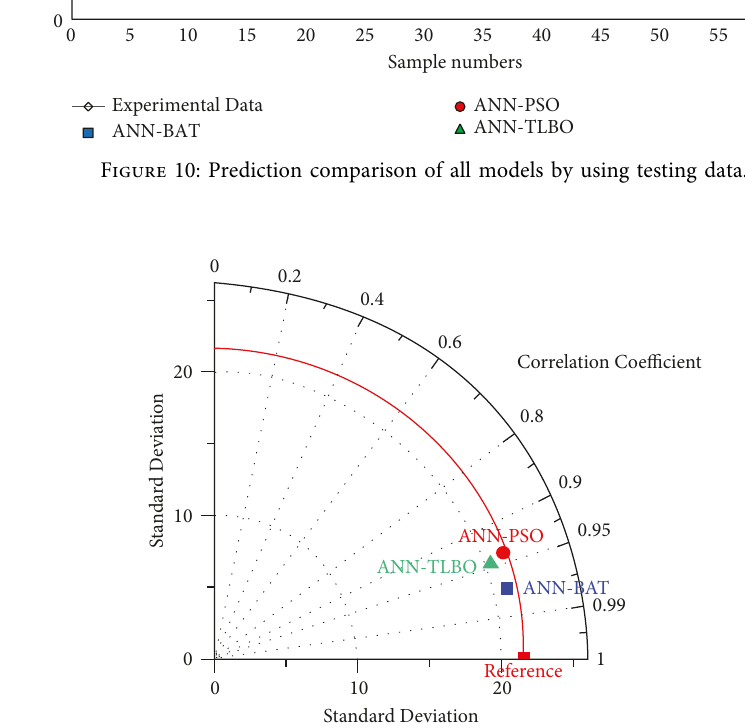
Figure 11: Taylor diagram visualization of different